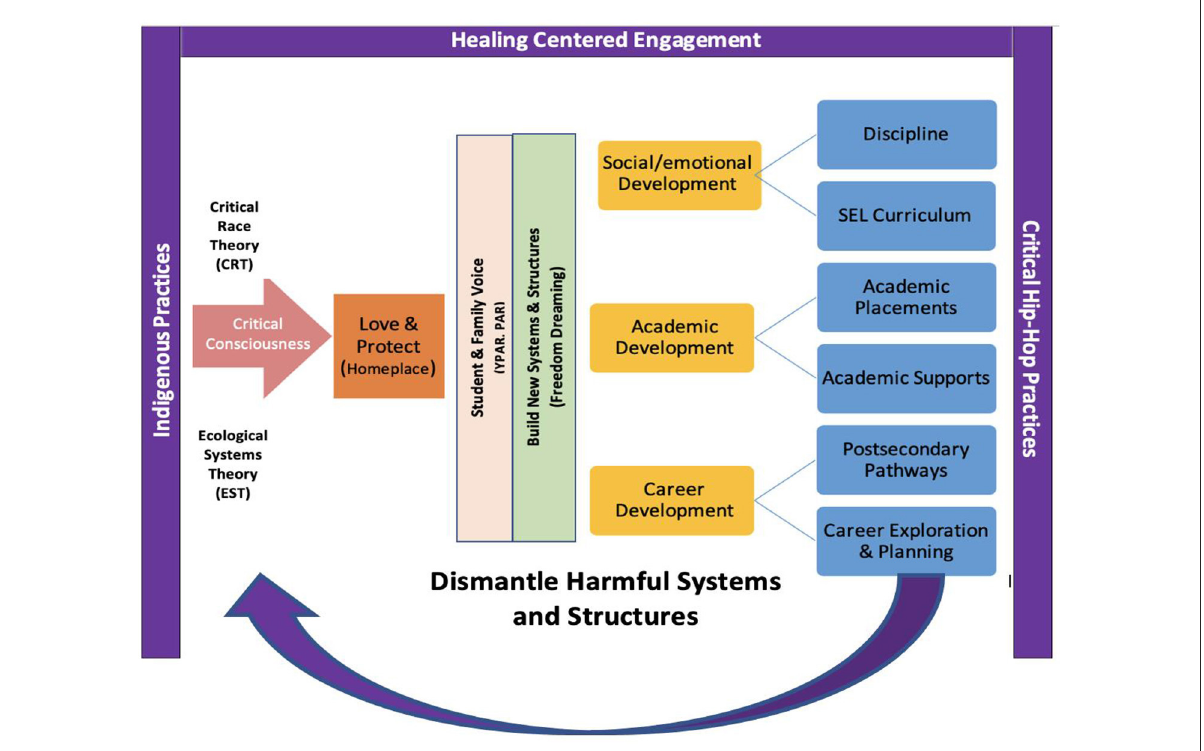
FIGURE1 Freedom dreaming in school counseling. Adapted from: Mayes and Byrd (2022) antiracist school counseling framework.